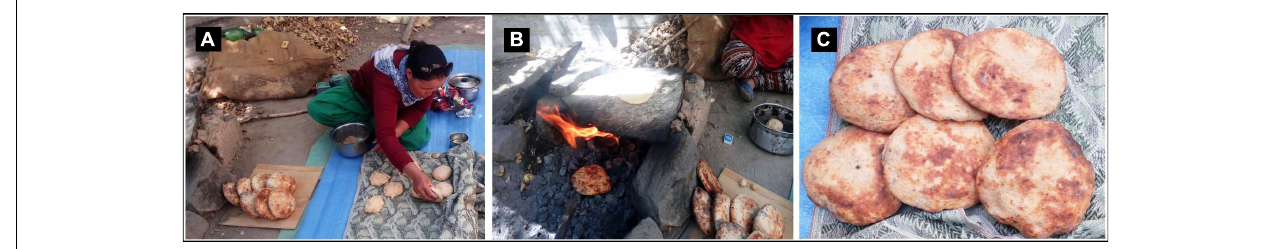
FIGURE 1 | | Traditional process of khambir preparation. After overnight incubation of wheat flour and starter (yeast or buttermilk), the fermented dough is divided, and ball shaped by hand (A) . The handmade round-shaped dough is baked over a hot stone and then under direct fire (B) . The final cleaned and polished brown bread is ready for consumption (C)